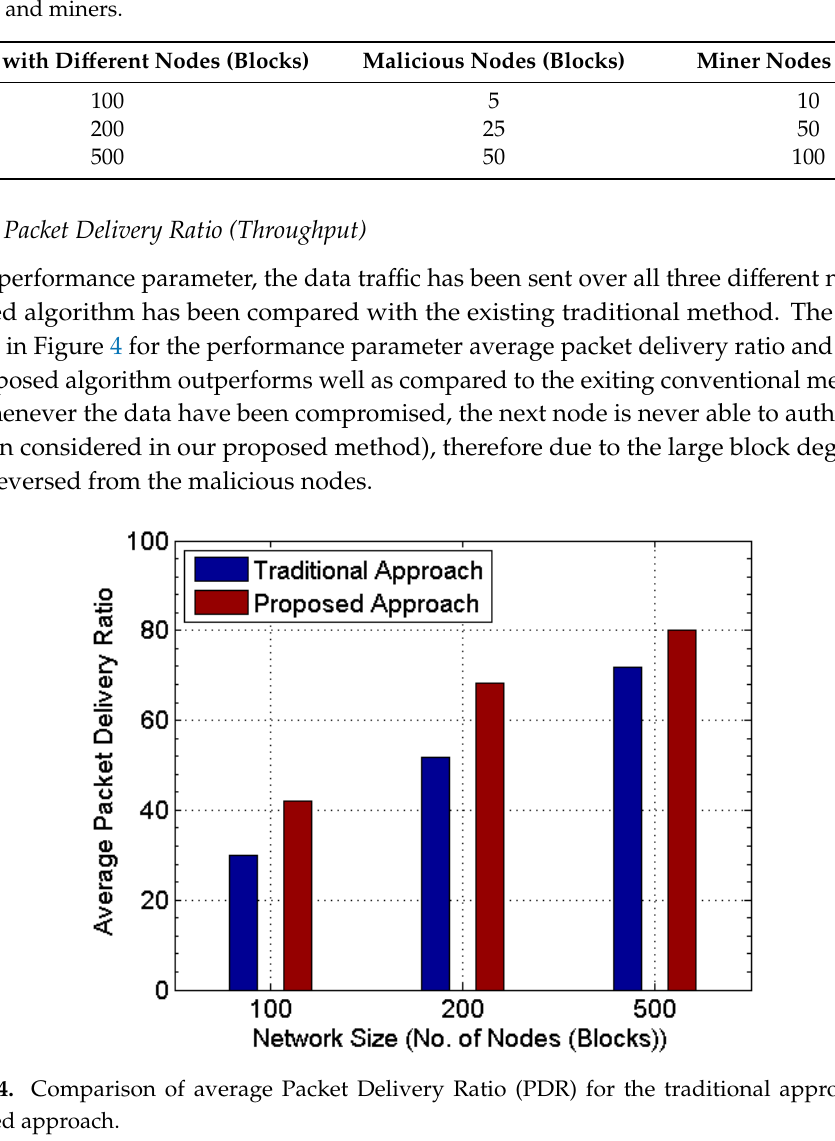
9 of 14 Table 3. Network configuration with miners and number of nodes (blocks) with malicious nodes